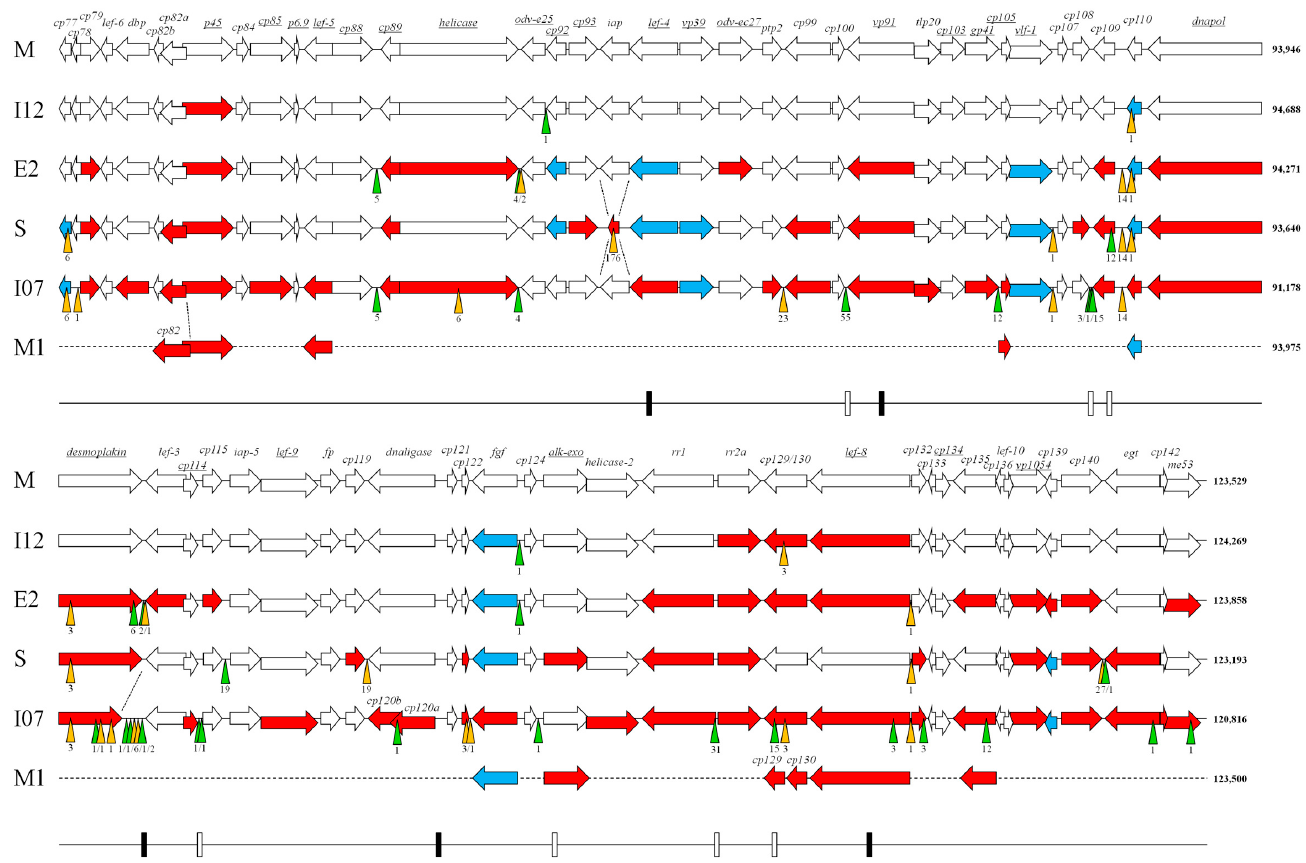
Figure 1. Graphical genome alignment of CpGV-M (M), CpGV-I12 (I12), CpGV-E2 (E2), CpGV-S (S) and CpGV-I07 (I07). CpGV-M was set as the reference sequence. For CpGV-M1, only major differences to all other isolates are shown. Arrows represent the relative length, orientation and position ORFs. Color code: white = ORFs are identical in their amino acid (aa) sequence to CpGV-M, red = ORFs are unique in their aa sequence, blue = ORFs with the same aa sequence, but different to CpGV-M. Deletions and insertions are represented by orange and green triangles, respectively, with their size given below. The putative transposable elements of CpGV-I12 and CpGV-E2 are shown by purple triangles. The bottom line represents the location of 13 CpGV-dispersed repeats (black boxes), 30 repeat regions (white boxes), and the major repeat region (light grey box).